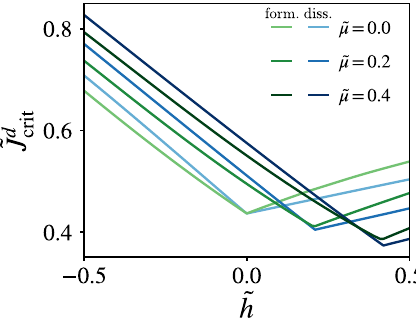
FIG. 9. Dynamical critical point. Dynamical critical coupling ˜ J d as a function of the external force crit intrinsic binding affinity ˜ μ . Note that be nonmonotonic with a global minimum whose location depends on ˜ μ